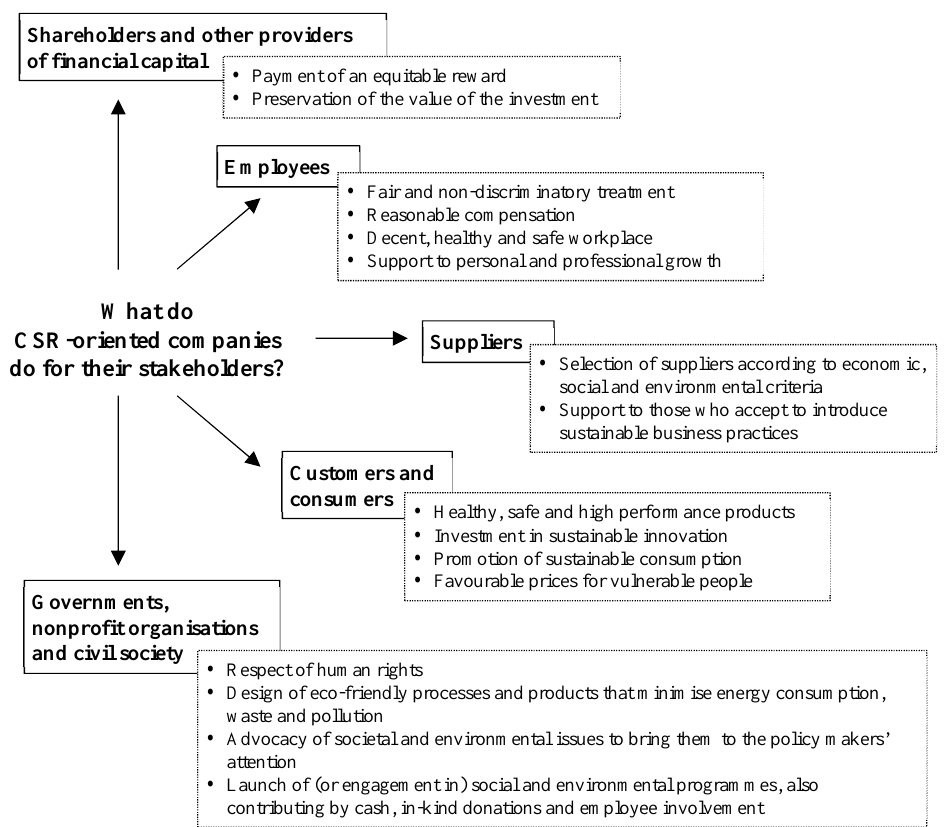
Figure 1: CSR-Oriented Companies and Stakeholders’